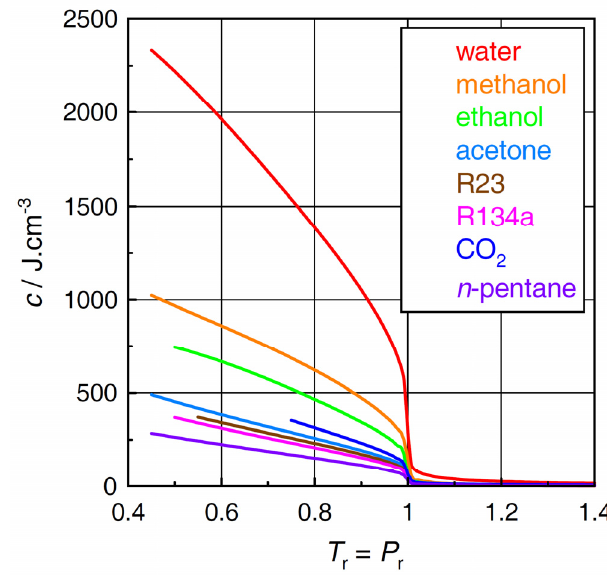
Figure 3. Cohesive energy densities c of the selected fluids.